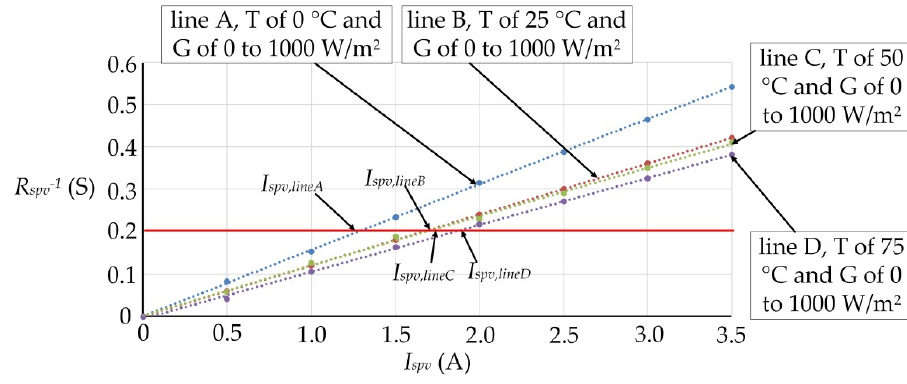
Figure 2. Relationship between R spv − 1 and I spv .